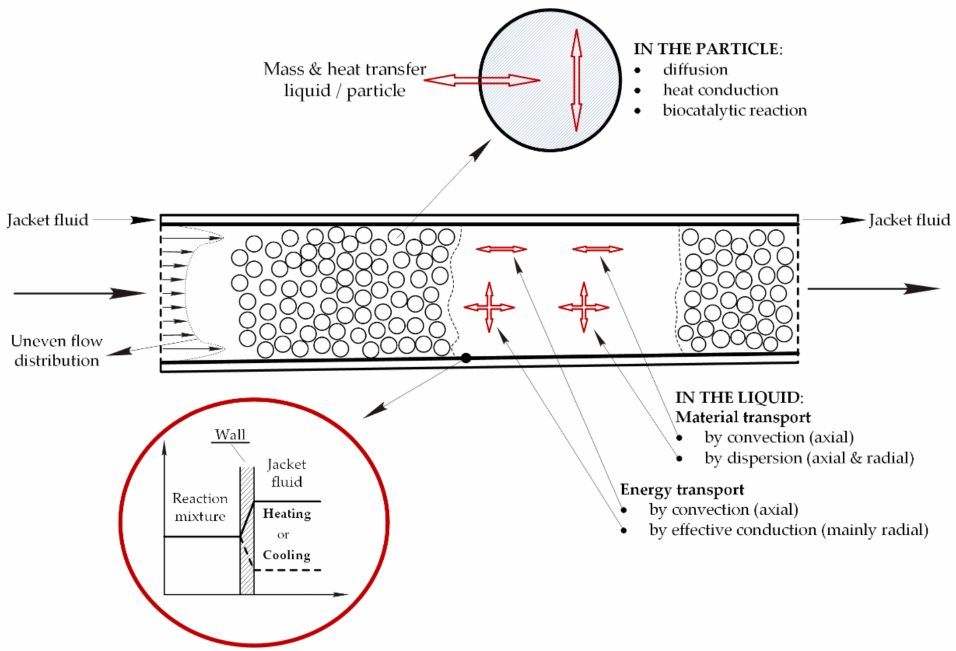
Figure 1. Mass and energy transport mechanism in a reactor packed with immobilized